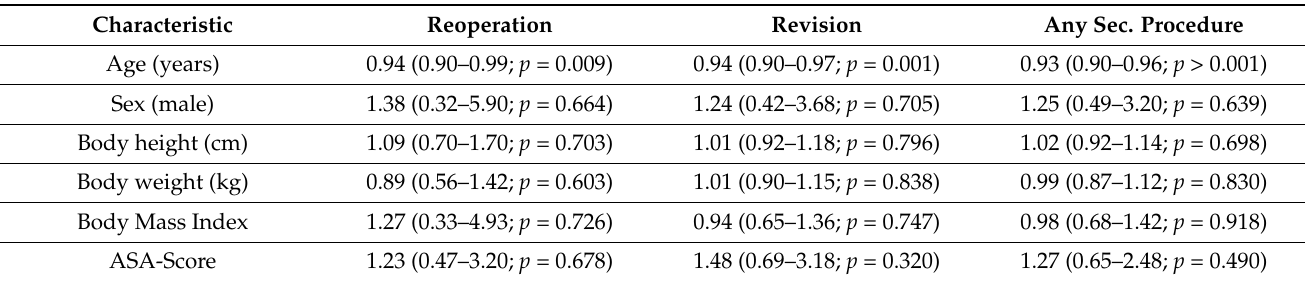
Table 4. Results of the binary logistic regression reporting the odds ratio for reoperation, revision, and any secondary procedure of each patient characteristic with the 95% CI and level of significance in